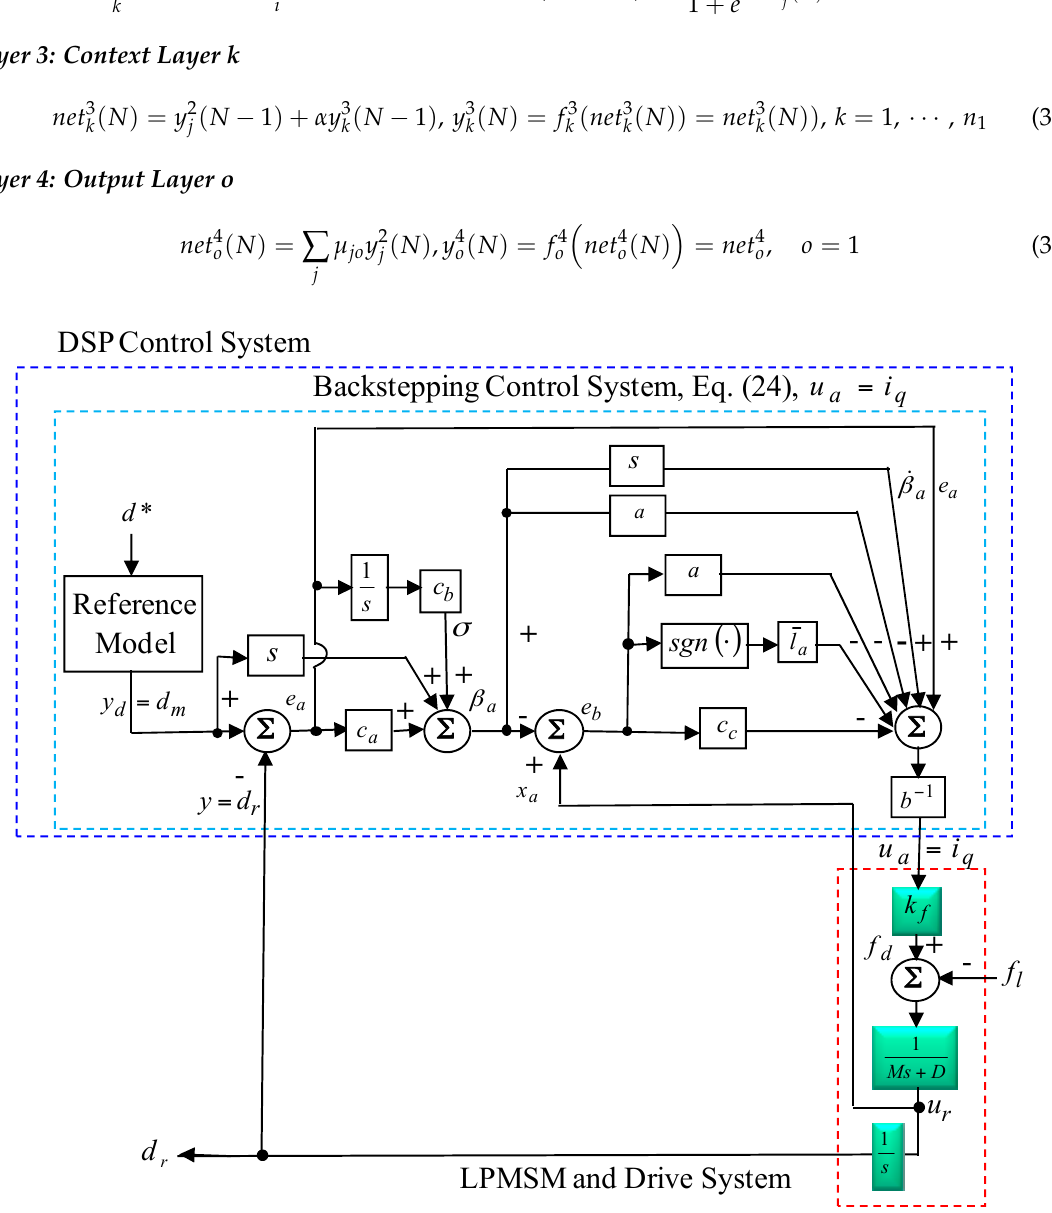
Figure 3. Block diagram of the posed backstepping control system using DSP control system.